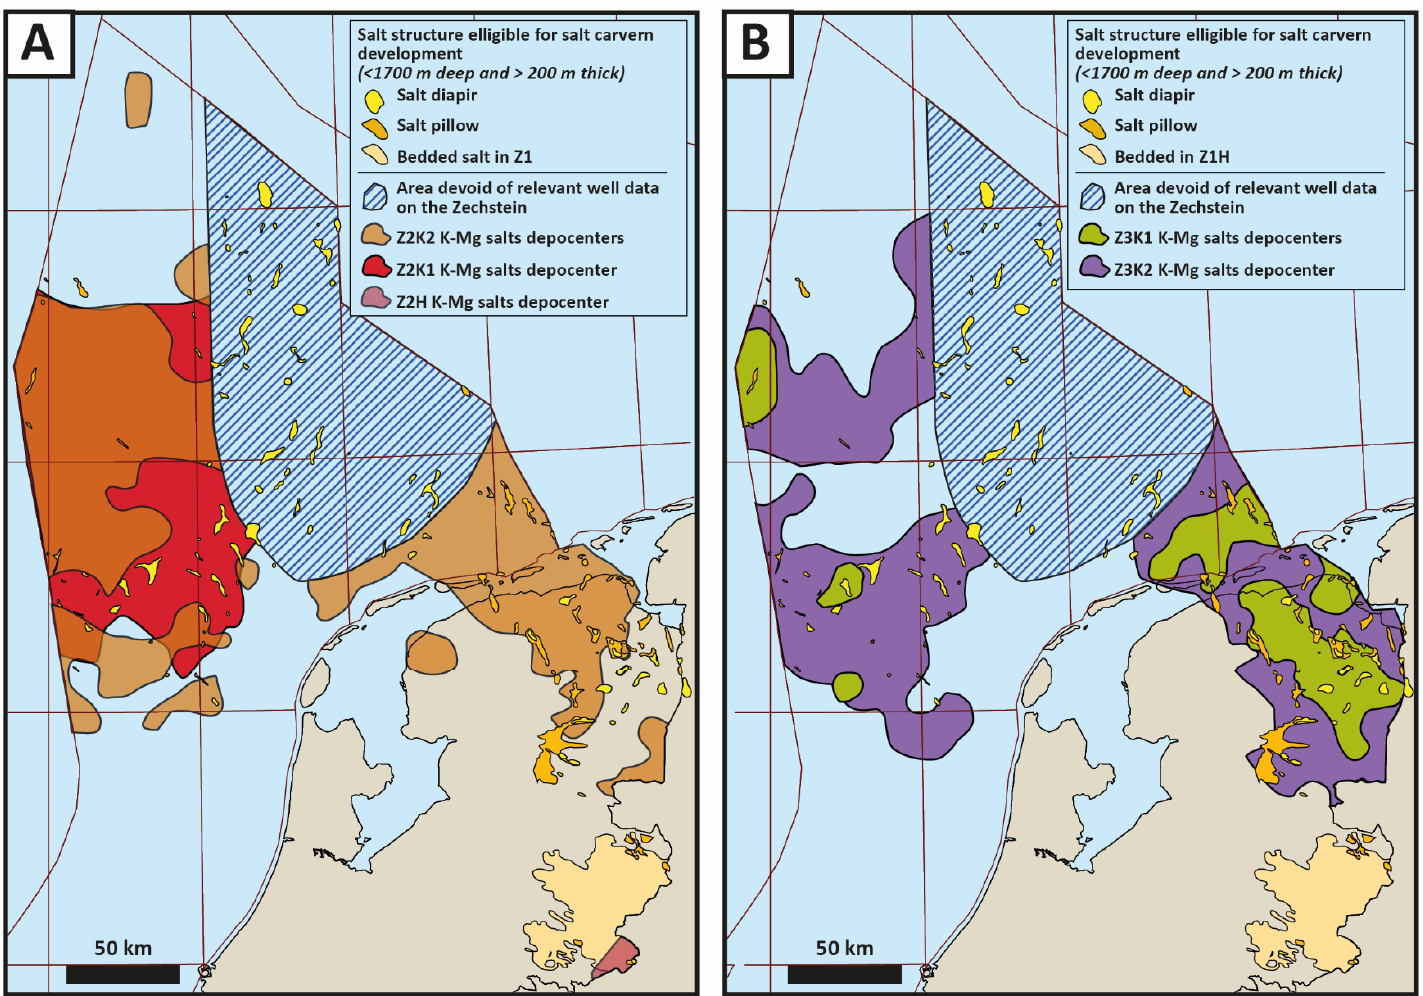
Figure 12. Maps identifying eligible salt structures for salt cavern development in the Zechstein and allowing us to assess the risk of encountering K–Mg salts in the Z1 and Z2 cycles ( A ) and in the Z3 cycle ( B ). The identification of the salt pillow and salt diapirs is modified from [102].